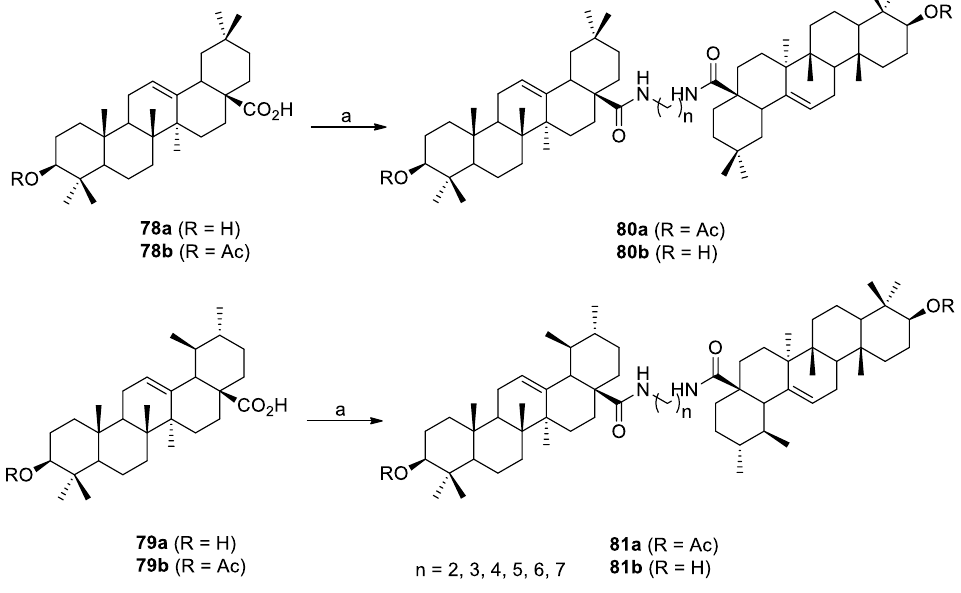
Figure 16. Ursolic acid ( 78a ), oleanolic acid ( 79a ), and dimers 80b and 81b